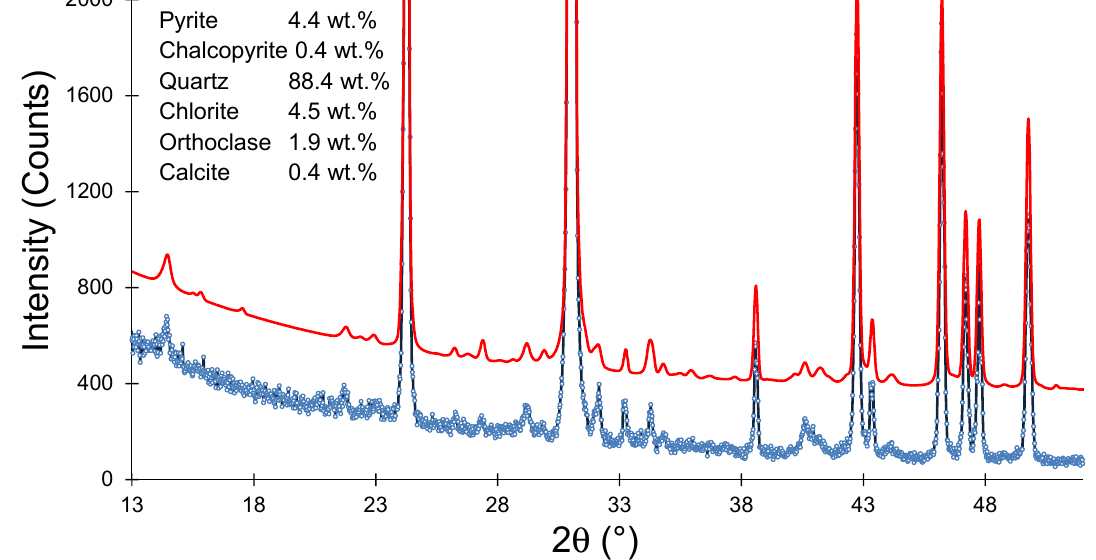
Figure 8. Rietveld analysis of standard laboratory XRD data of a simple Cu bearing ore, showing sensitivity to low wt % mineral fractions. The lower line represents the experimental data whereas the upper line (displaced by 300 in y for clarity) represents the simulated